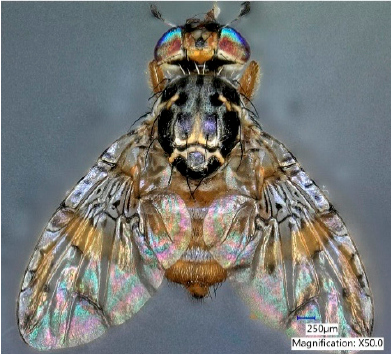
Figure 1. Adult male Ceratitis capitata (Wied.). Photo credit: Teresa Narvaez (USDA-ARS, SHRS).